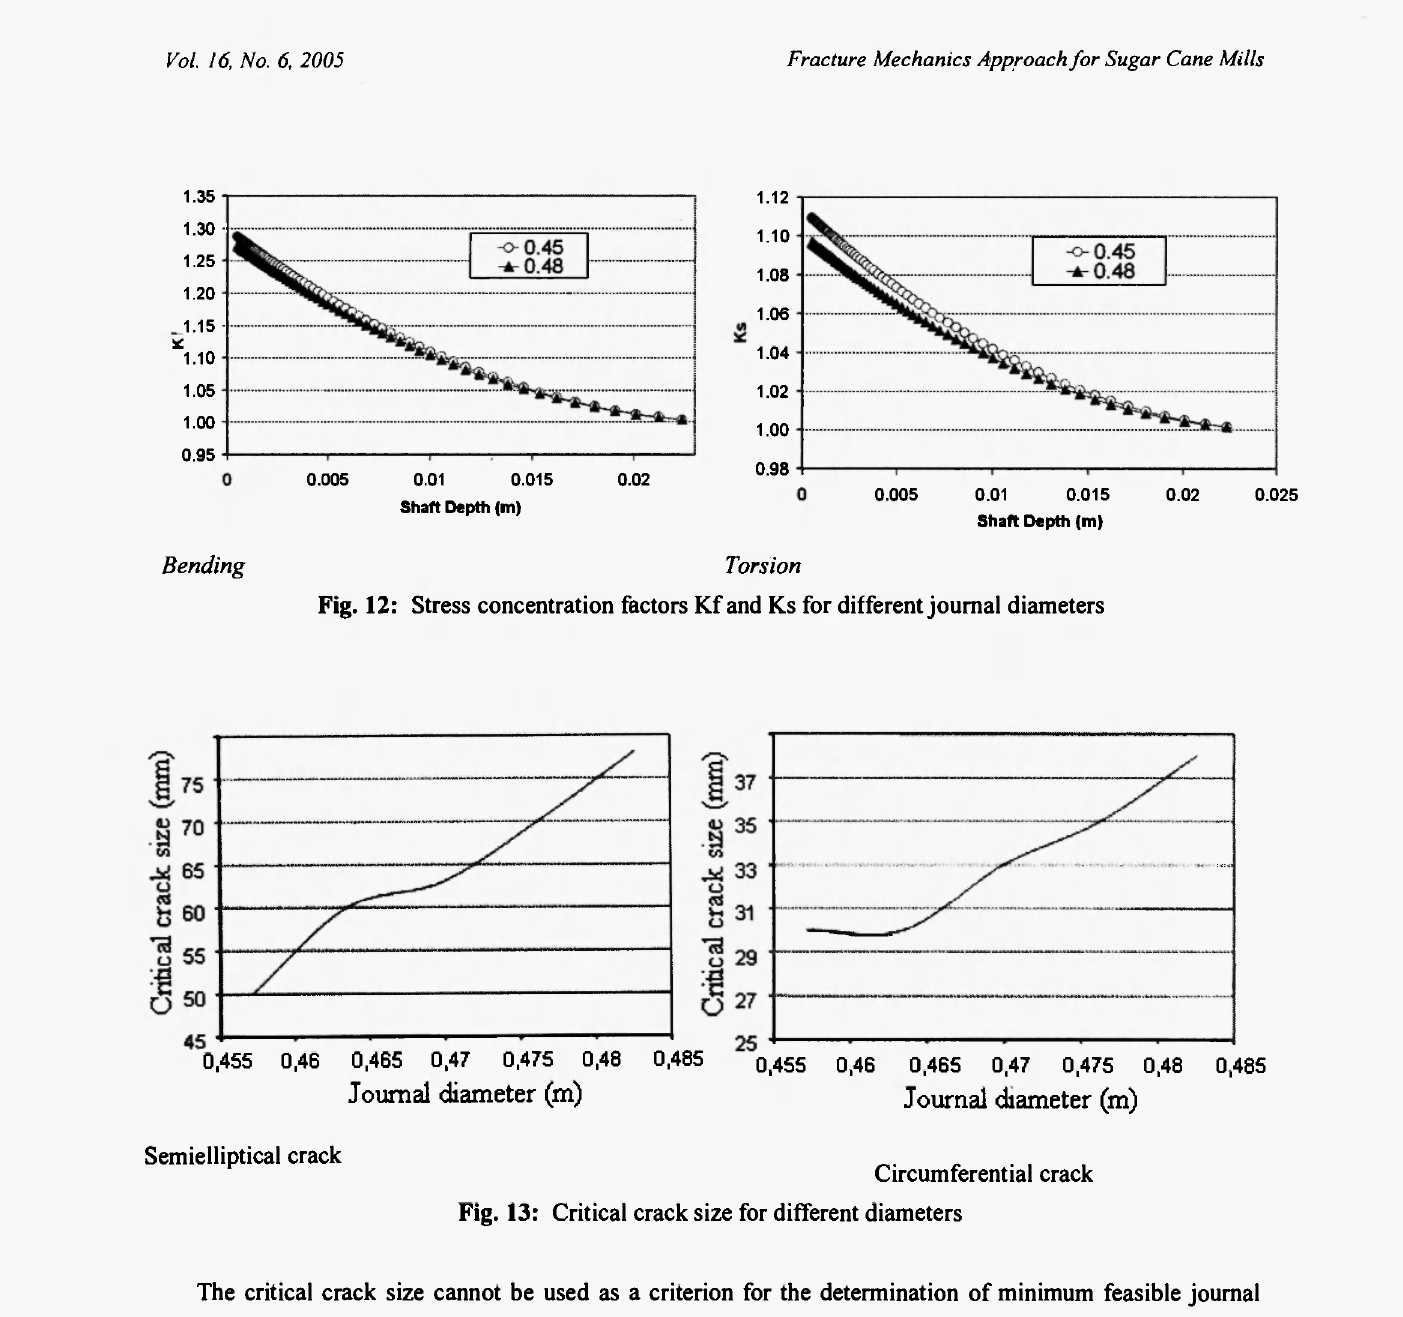
Fig. 13: Critical crack size for different